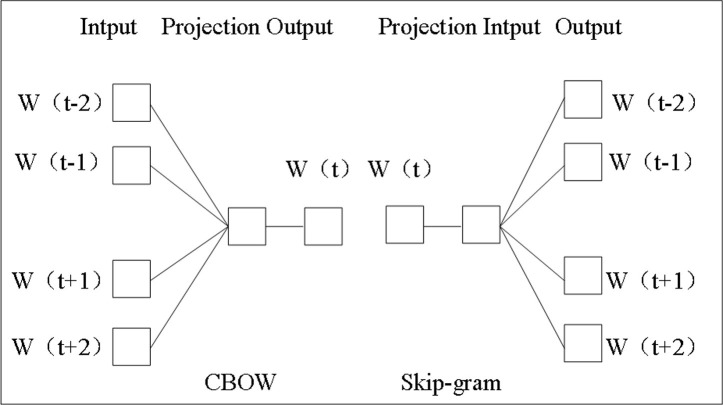
Network structure of the review information of users and scenic spots.